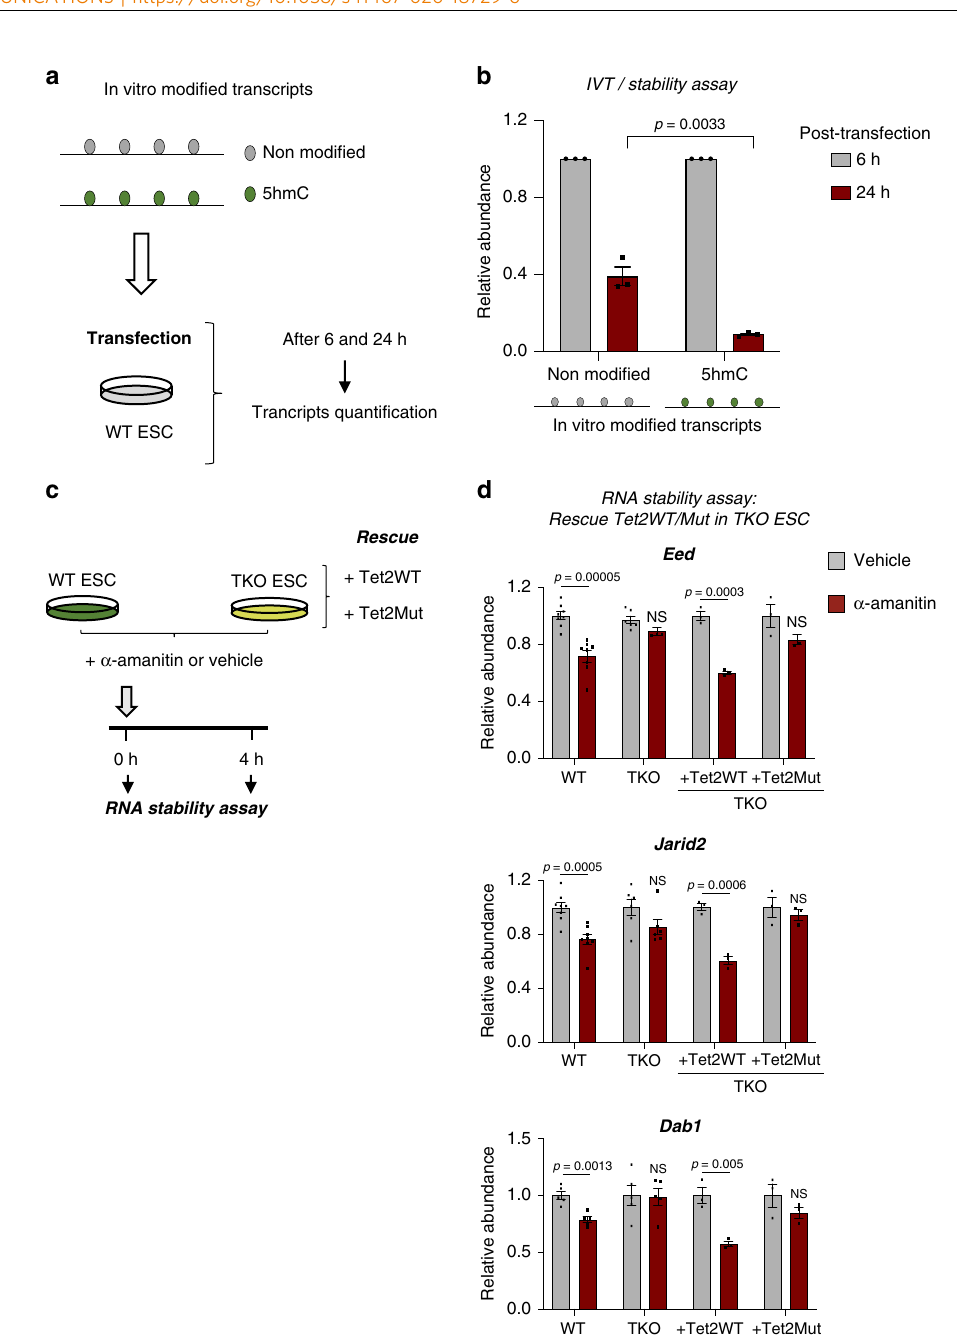
Fig. 6 Tet-mediated 5hmC reduces the stability of core pluripotency transcripts. a Scheme illustrating the protocol used to quantify in vitro unmodi fi ed and 5hmC-modi fi ed transcript abundance after ESC transfection. b In vitro 5hmC-modi fi ed transcripts are less stable than their unmodi fi ed counterparts. Unmodi fi ed and 5hmC-modi fi ed transcript abundances were measured by RT-qPCR at 6 and 24 h post-transfection. RNA levels were normalized to endogenous Gapdh and relative to the transcript level at 6 h post-transfection. Data are means± SEM ( n = 3 independent experiments, two-tailed Student ’ s t -test). c Scheme illustrating the protocol used to inhibit transcription with α -amanitin in WT and TKO ESCs before performing stability assays to detect rescue of the destabilization process by Tet2WT or its catalytic mutant (Tet2Mut). d Tet2WT but not Tet2Mut restores destabilization of Eed , Jarid2 , and Dab1 transcripts in TKO ESCs. 18S rRNA was used as an internal calibrator. Error bars indicate ± SEM for at least three independent experiments. (Two- tailed Student ’ s t -test; NS not signi fi cant). Source data are provided as a Source Data